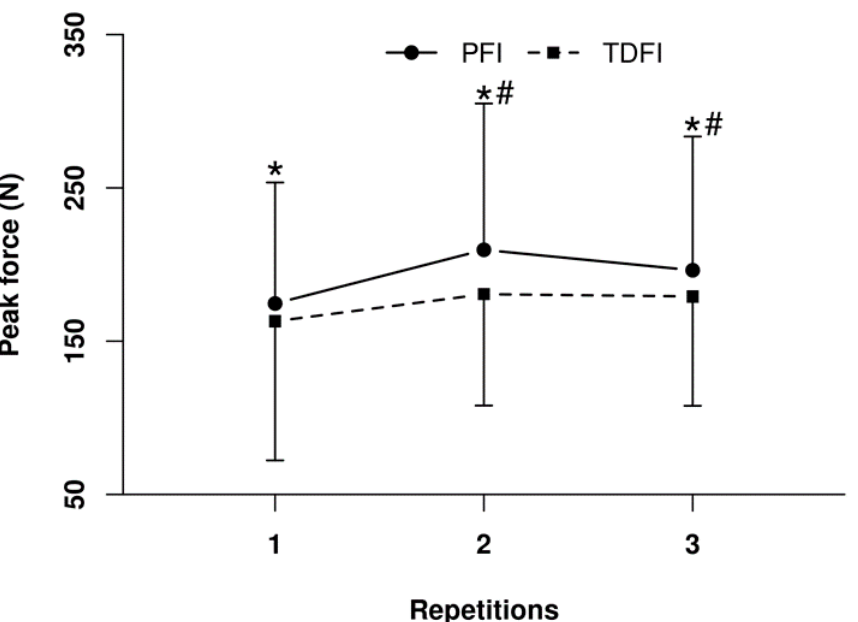
Figure 7. Peak force produced during the 3 s maximal voluntary isometric contraction of the right plantar flexors after the 20 km time-trial for the programmed (PFI) and thirst-driven fluid intake (TDFI) strategies. * p < 0.05 for difference between conditions, # p < 0.05 for difference with first repetition. Values are means ± SD.